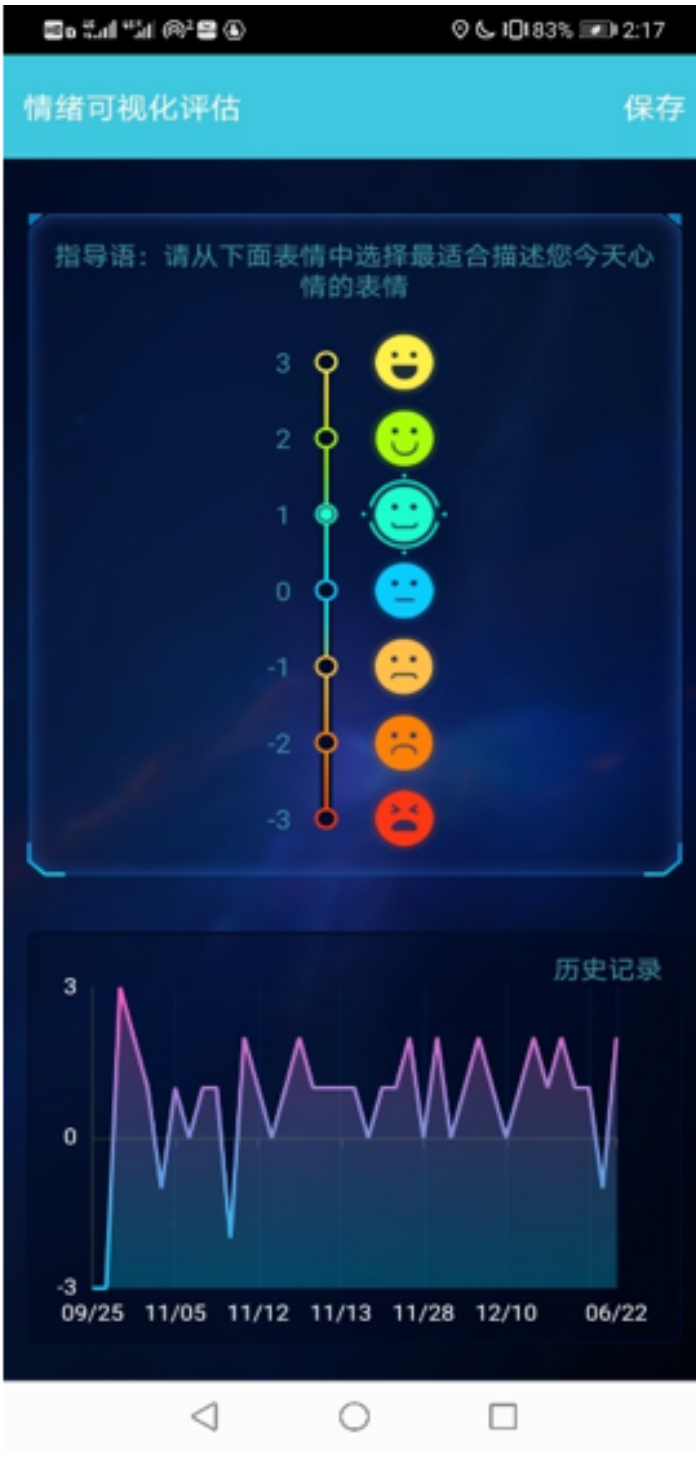
Figure 3. Screenshot of filling the Visual Analog